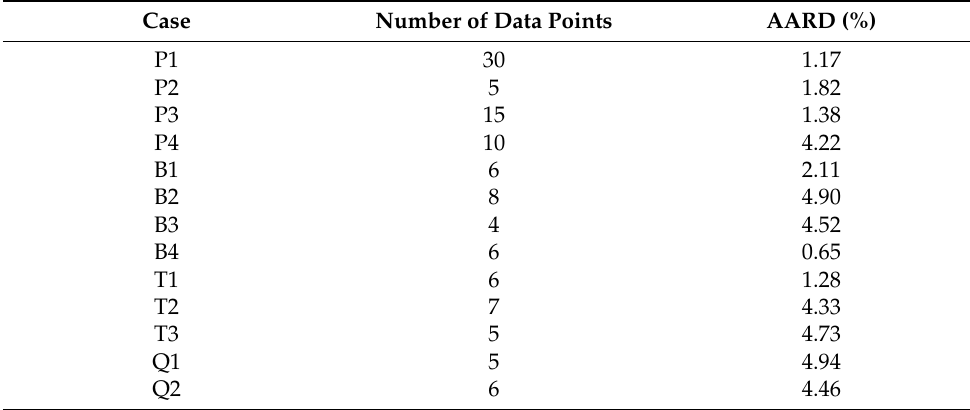
Table 5. AARD calculated for all case